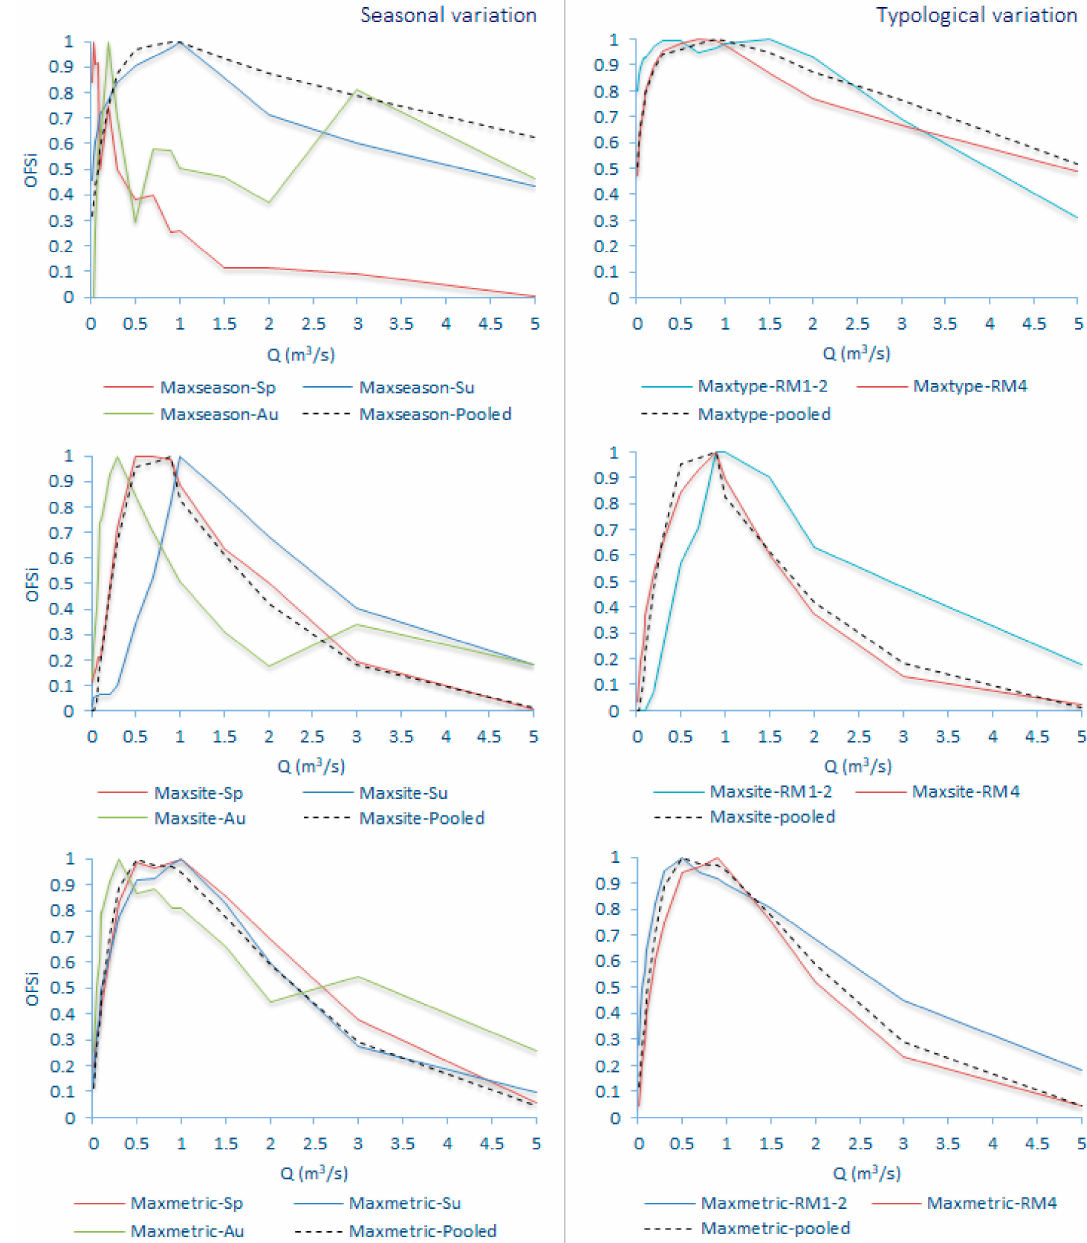
Figure 9. Seasonal and typological variation in the selection of the optimal flow scenario (OFS) for the Oinoi reach within the various habitat-suitability calculation-normalization options (Sp: Spring; Su: Summer; Au: